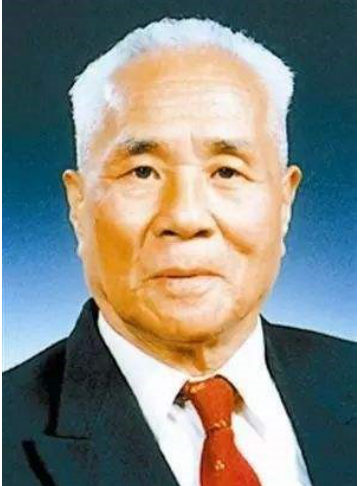
Figure 2. Chengyi Fu (7 October 1909–8 January 2000). Source: courtesy of the Chinese Academy of Sciences.